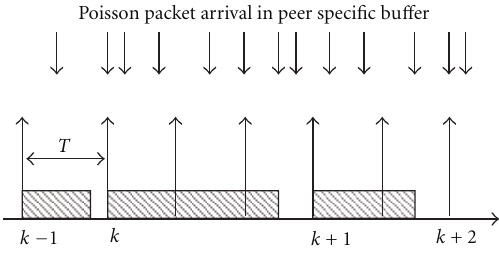
Figure 6: The system observation instants are given by k . The batch transmission time is shown by hatched